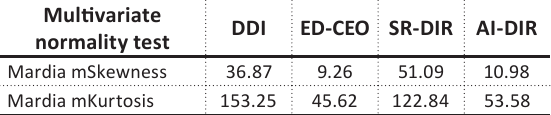
Table 7. T -test of average contrast between the constructs and duality CEO-Chairman